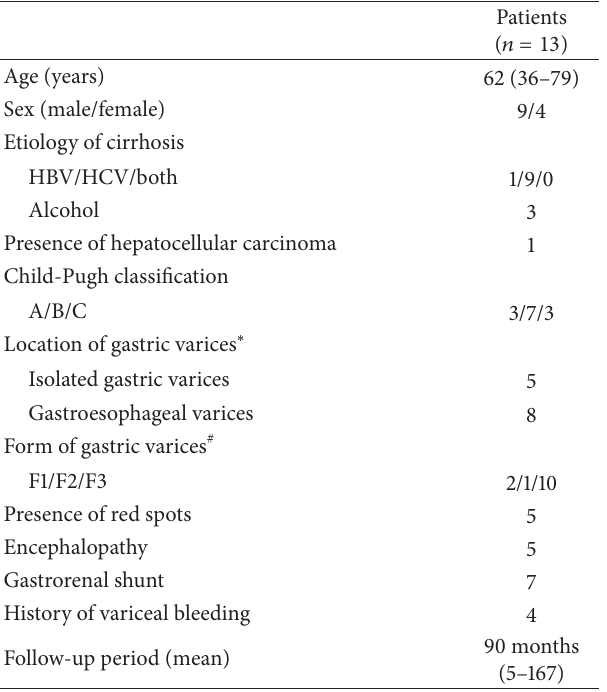
Table 1: Patient